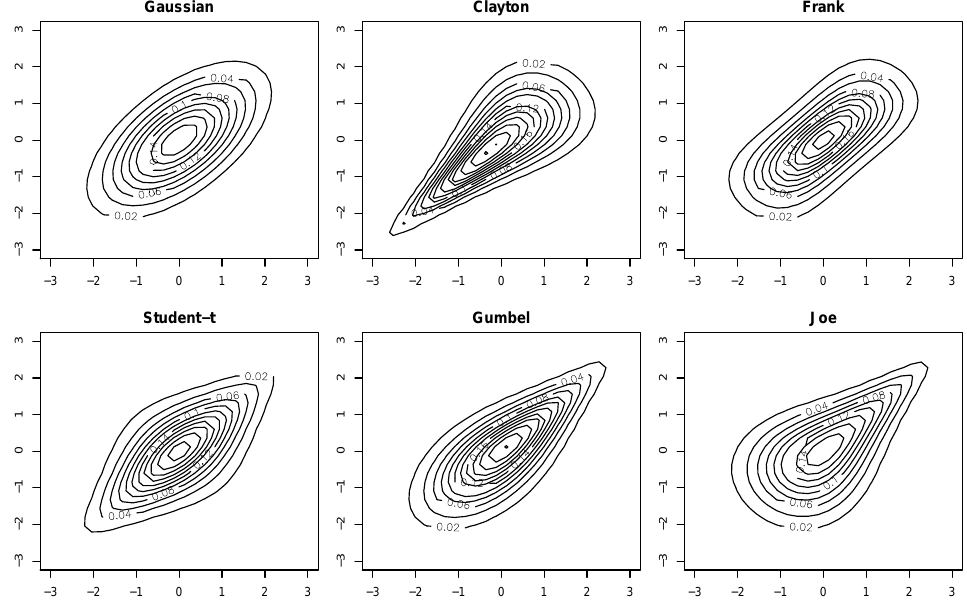
Figure 2. Contour plots of bivariate copula densities. Elliptical copulas in the left column: Gaussian ( ρ = 0.6) and Student- t ( ρ = 0.6, df = 3). Bivariate Archimedean copulas in the middle and right columns: Clayton, Frank ( α = 5), Gumbel and Joe ( α = 2). All marginal distributions are standard